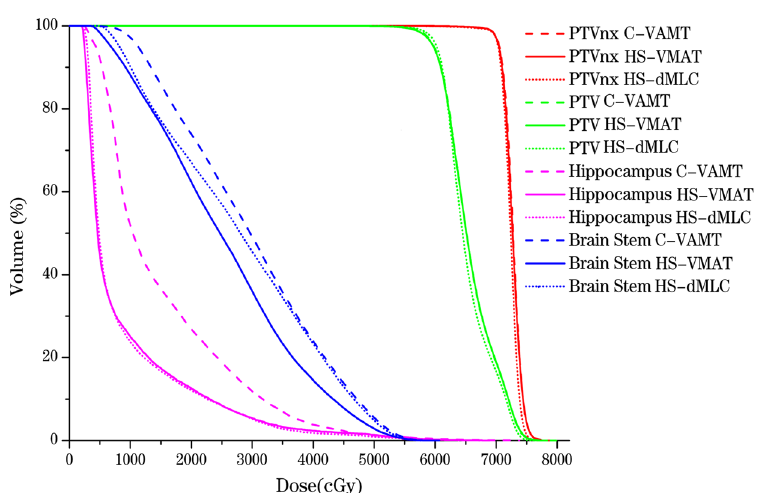
Figure 1. The DVH comparison of three kinds of